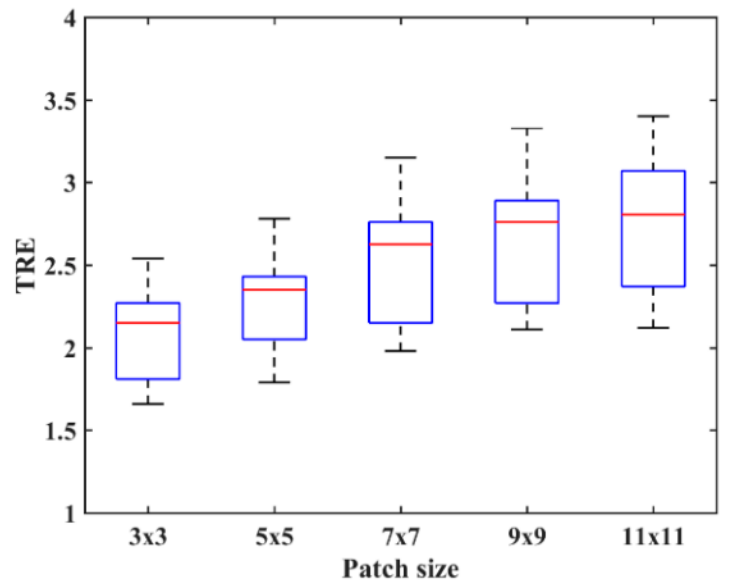
Figure 5. Target registration error (TRE) for the PSR method using the various patch sizes.